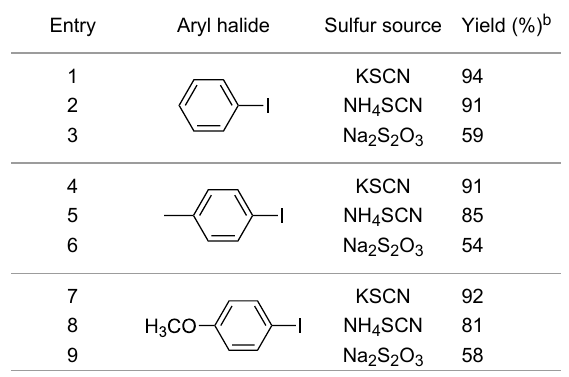
Table 2: Nano CuO catalyzed C–S cross-coupling of iodobenzene with different sulfur sources. a Entry Aryl halide Sulfur source Yield (%)